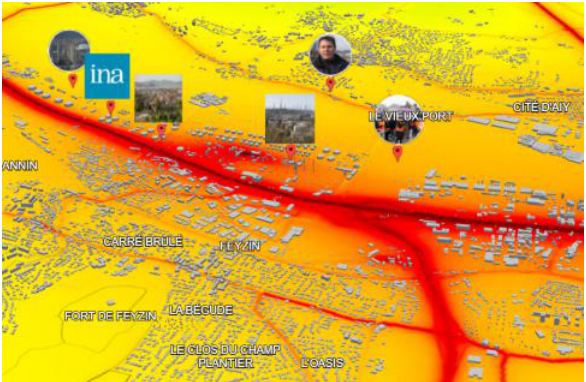
Figure 6. The 3D geo-pinned multimedia modality used in the context of the Chemistry valley. The pins show an overview of the different media available in the